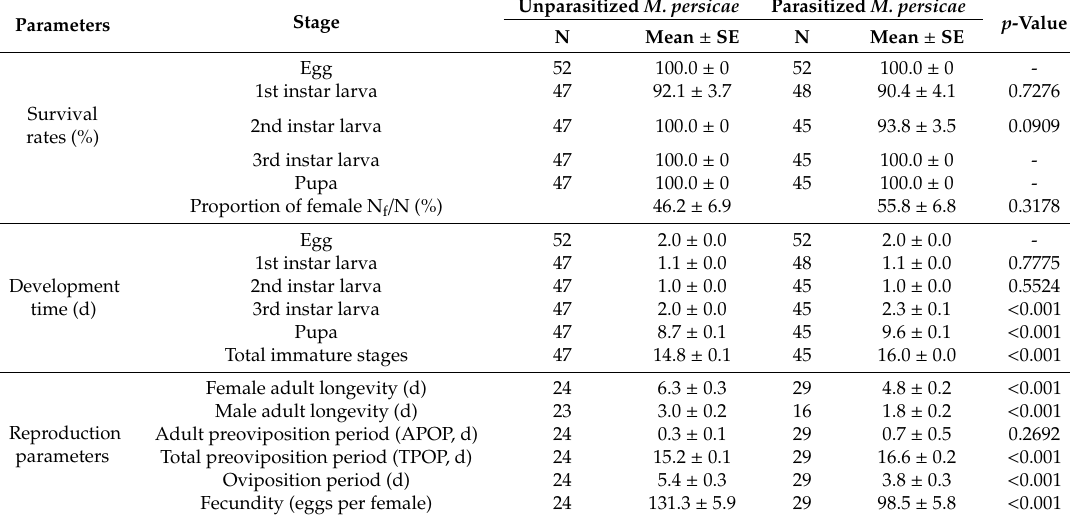
Table 1. The survival rates, development time (mean ± SE) of various life stages and sexes, reproduction parameters of Aphidoletes aphidimyza that fed on unparasitized and parasitized Myzus persicae by Aphidius